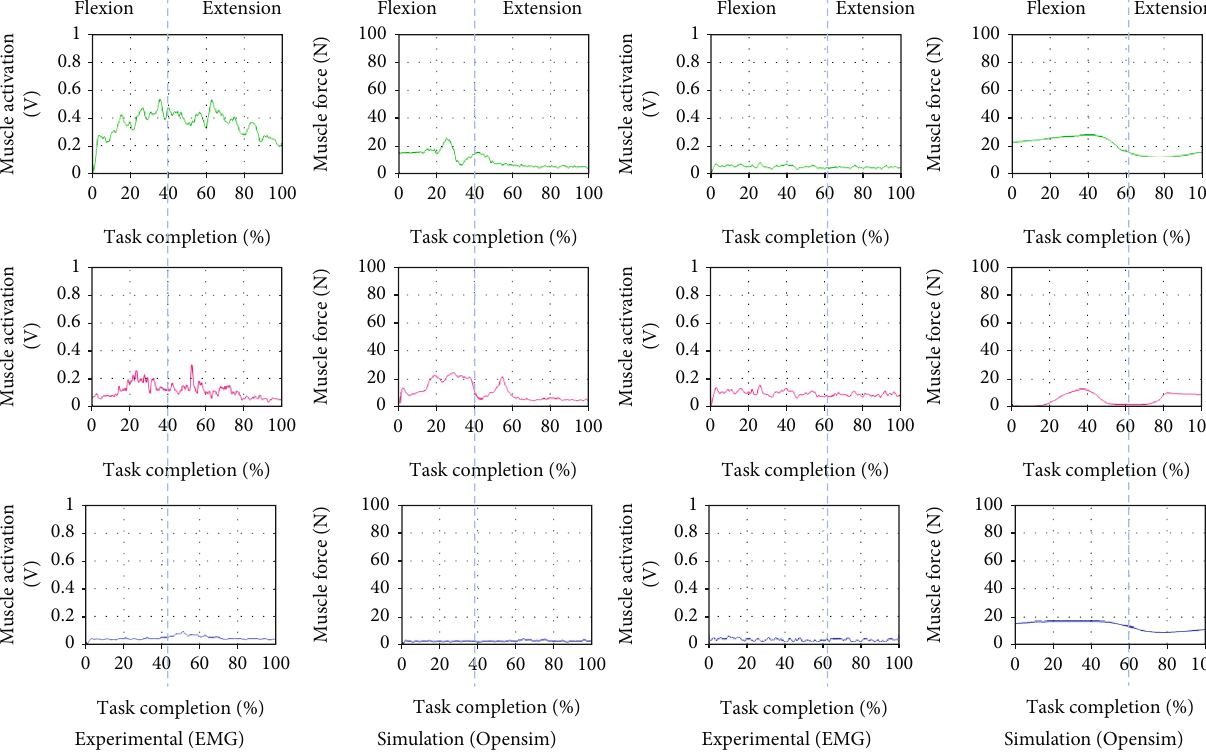
Figure 12: Comparison of EMG from experimental and muscle activations computed from OpenSim resulting in three muscle force brachioradialis (green), biceps (magenta), and triceps (blue) for inner elbow fl exion and extension motion with and without the assistive